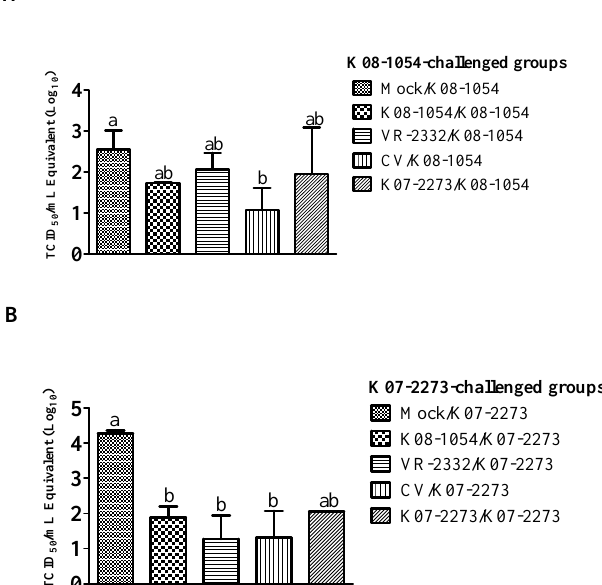
Figure 9. Quantification of residual viral lung load in challenged pigs at 42 dpv. Residual viral load in the lungs of K08 ‐ 1054 ‐ challenged groups at 42 dpv ( A ). Residual viral load in the lungs of K07 ‐ 2273 ‐ challenged groups at 42 dpv ( B ). The virus titers were calculated based on the standard curve of the cycle threshold number plotted against the known virus titer of VR ‐ 2332. The bars represent the means, and the error bars represent the standard error of the mean (SEM). Bars with different letters depict values significantly different from each other ( p < 0.05).